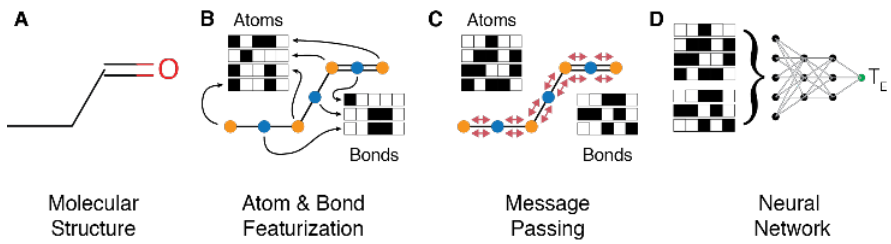
Figure 2. Model for predicting elution times from molecular structures: ( A ) The 2D representation of the molecule is used as input and converted into a connectivity graph. ( B ) Atom and bond properties are extracted from the connectivity graph. ( C ) Properties from neighboring atoms and bonds are transmitted and mixed via four rounds of message passing. ( D ) The final properties at each atom and node are collated and passed through a four-stage set2set neural network to predict the MM retention time (TE).